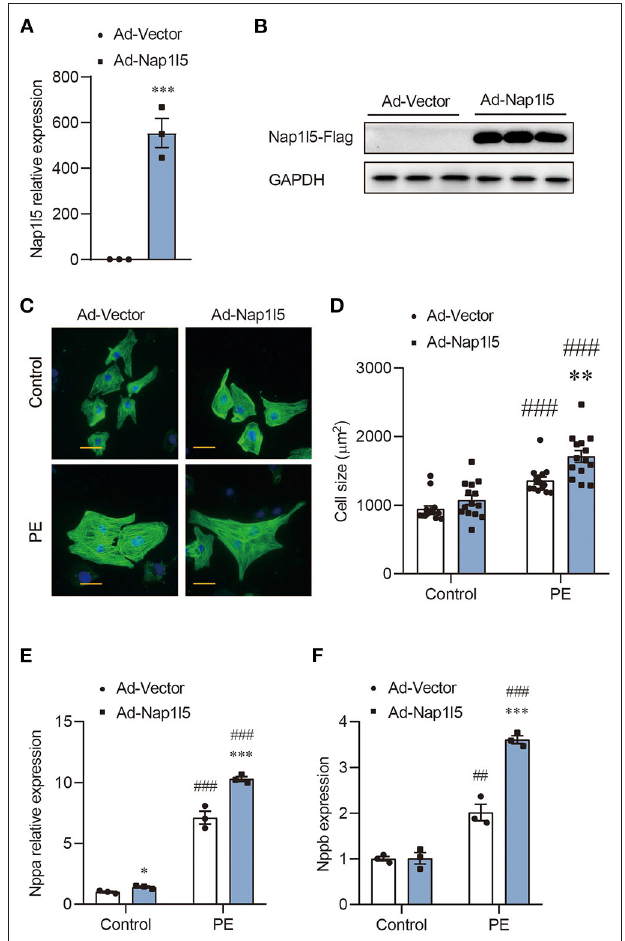
FIGURE 2 | NAP1L5 overexpression promotes PE-induced cardiomyocyte hypertrophy. (A) Expression of Nap1l5 in NRVMs infected with adenovirus vector (Ad-Vector) or that expressing rat Nap1l5 (Ad-Nap1l5) measured by qRT-PCR. *** P < 0.001 vs. Ad-Vector. n = 3. (B) Immuoblots showing the validation of NAP1L5 overexpression at the protein level using an anti-FLAG antibody. GAPDH was used as an internal control. n = 3. (C) Representative α -actinin-staining images of NRVMs infected with Ad-Vector or Ad-Nap1l5, with and without PE treatment. Scale bar: 20 µ m. (D) Quantification of cell size measured by WGA staining in NRVMs infected with Ad-Vector or Ad-Nap1l5, with and without PE treatment. ** P < 0.01 vs. Ad-Vector; ### P < 0.001 vs. Control. n = 15. (E,F) Impact of Nap1l5 overexpression on PE-induced expression of Nppa (E) and Nppb (F) . ** P < 0.01, *** P < 0.001 vs. siNeg; # P < 0.05, ### P < 0.001 vs. Control. n =